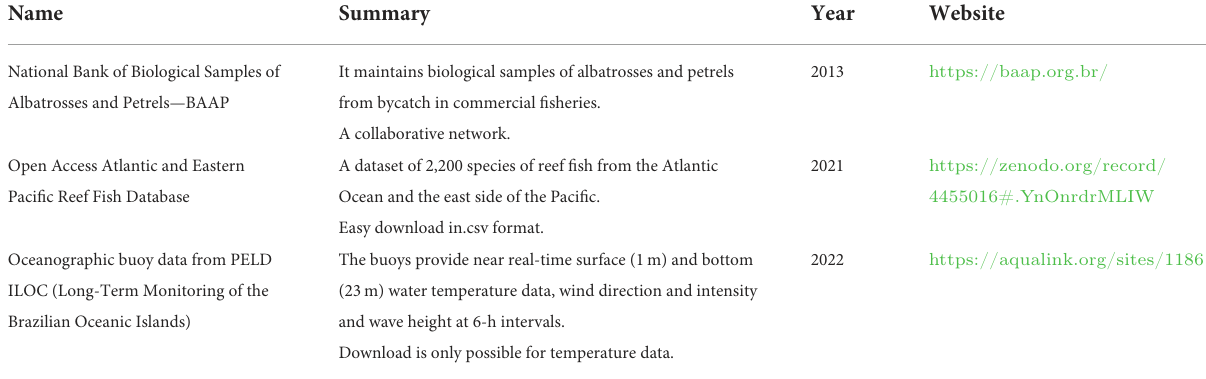
TABLE 3 Some initiatives to share environmental/marine data in